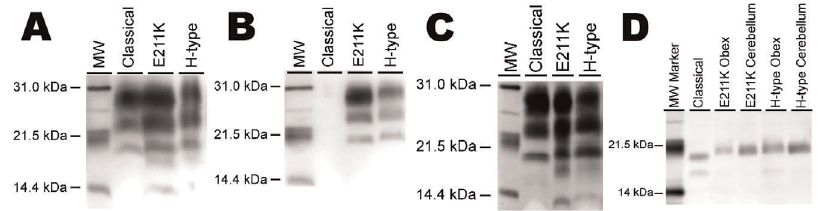
Figure 5. Western blot analysis with a panel of monoclonal antibodies. ( A ) Samples from five brain regions of calf # 83 demonstrate the characteristic 3-band profile of PrP Sc when developed with mAb 6H4. The unglycosylated, monoglycosylated, and diglycosylated bands are of similar intensity. Note the presence of an additional band at approximately 23 kDa in the sample from cerebellum. ( B ) Western blot analysis with monoclonal antibody P4 showing the characteristic 3 band profile of PrP Sc for both E211K and BSE-H, but an absence of detectable PrP Sc for classical BSE. ( C ) Western blot analysis with mAb SAF-84 showing comparison of PrP Sc profiles in brain of classical, E211K, and H-type BSE. E211K and H-type BSE have a 4 th band at 14 kDa, whereas classical BSE does not. ( D ) All BSE-H samples appear similar after PNGase F treatment (mAb 6H4). Samples were loaded at 0.6–0.8 mg (A–C) or 0.1–0.3 mg (D) equivalents of brain tissue per lane. Molecular weight standards flank the blot and the molecular weight in kDa is indicated to the left of the